Question: According to the figure, is the described quantity increasing or decreasing?
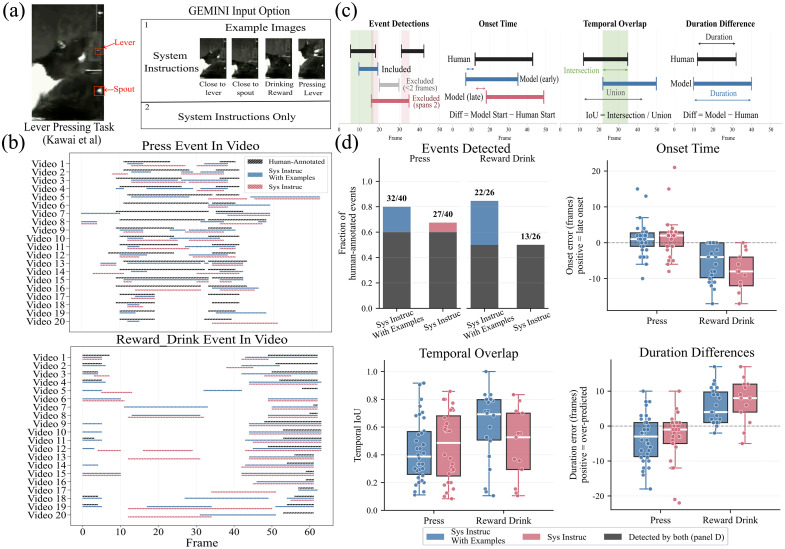
Answer: increasing